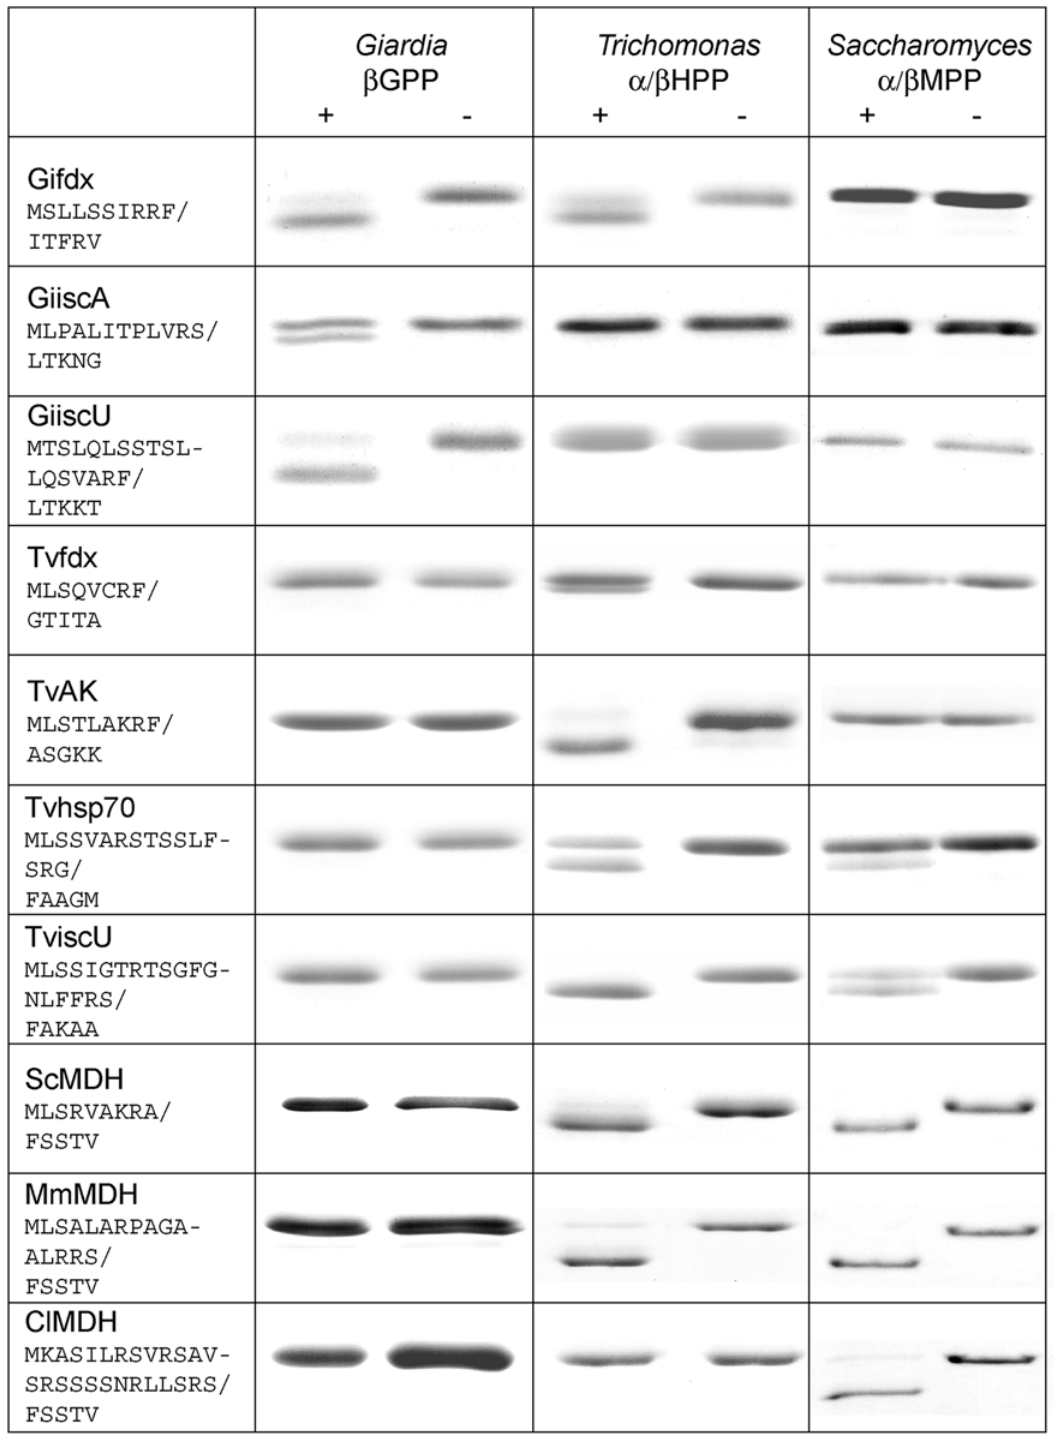
Figure 2. Comparative processing of mitosomal, hydrogenosomal and mitochondrial proteins by b GPP, a / b HPP and S.cerevisiae a / b MPP. The sequence of the demonstrated N-terminal mitochondrial, mitosomal or hydrogenosomal targeting presequences is indicated for each substrate protein with / indicating the cleavage site. Processing of Giardia intestinalis mitosomal presequences (Gifdx, [2Fe2S] ferredoxin; GiiscA and GiiscU, metallochaperones involved in FeS cluster assembly), Trichomonas vaginalis hydrogenosomal presequences (Tvfdx, [2Fe2S] ferredoxin; TvAK, adenylate kinase; Tvhsp70, heat shock protein 70; TviscU, metallochaperone involved in FeS cluster assembly) and mitochondrial presequences (ScMDH, Saccharomyces cerevisiae malate dehydrogenase; MmMDH, Mus musculus MDH; ClMDH, Citrullus lanatus MDH) was tested. Reaction products were separated by SDS-PAGE. Shift in protein mobility indicates cleavage of a targeting presequence. The sites of cleavage indicated by slashes in left column were determined by N-terminal amino acid sequencing. Substrates were incubated with ( + ) or without ( 2 ) the corresponding protease.